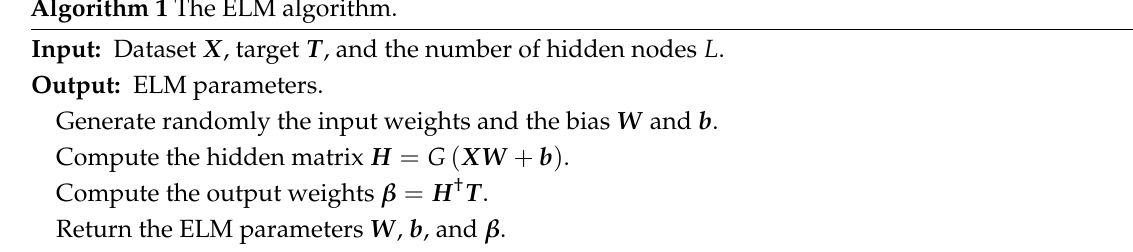
Algorithm 1 The ELM algorithm.